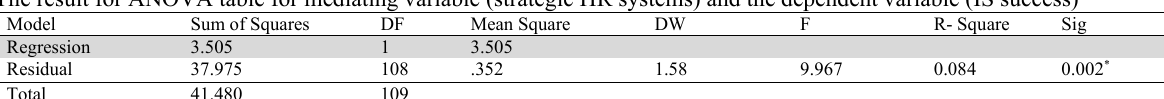
The result for ANOVA table for mediating variable (strategic HR systems) and the dependent variable (IS success)